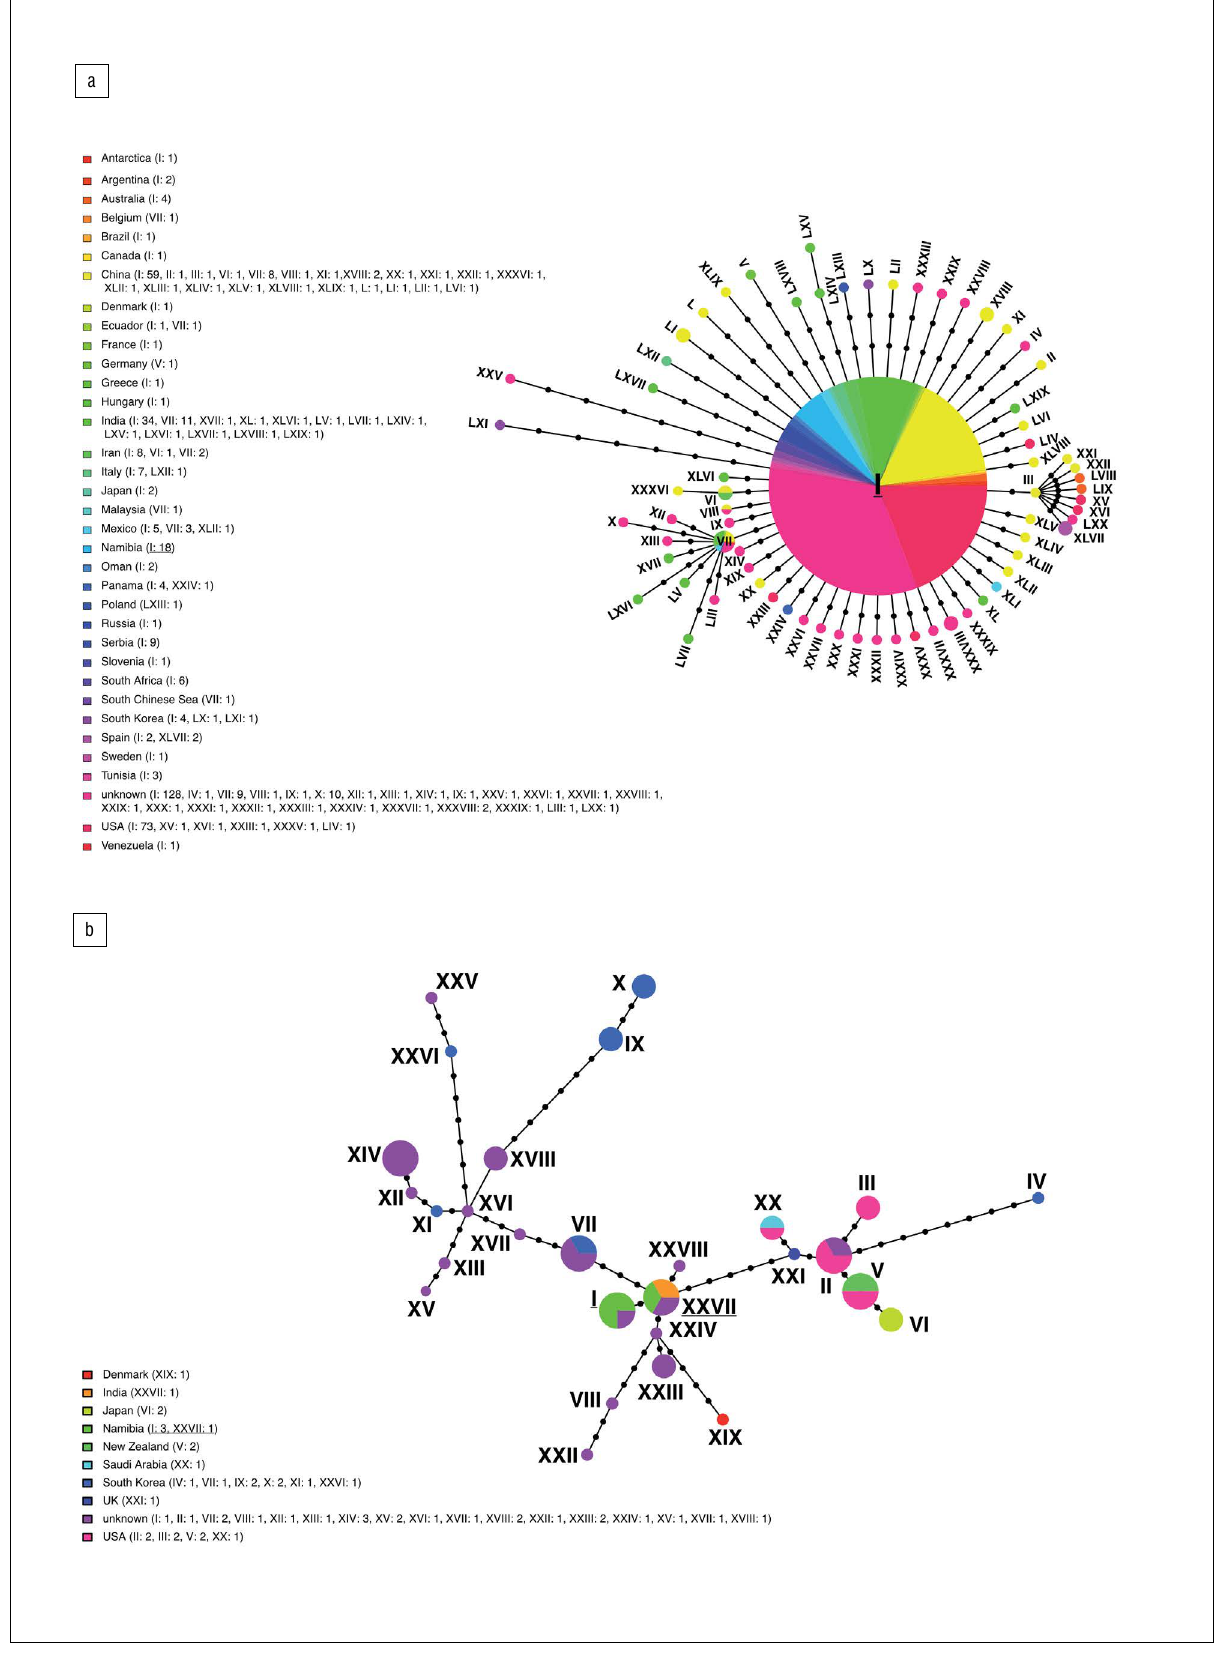
Figure 3: Minimum spanning tree of (a) ITS and (b) beta-tubulin 1 for Alternaria sequences. Roman numerals indicate individual haplotypes. Country of origin is colour-coded and text in parentheses indicates the number of sequences per haplotype per country of origin. Haplotypes containing taxa from this study are